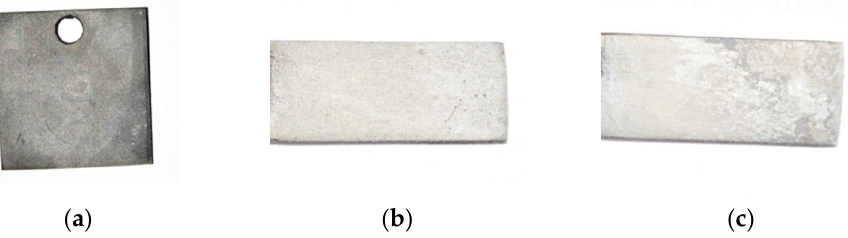
Figure 2. Images of the surface of phosphated steel samples obtained by a digital camera: ( a ) Un- painted phosphate coating from a modified solution; ( b ) White phosphate coating from a solution with the addition of zinc nitrate; ( c ) White phosphate coating from a solution with the addition of calcium nitrate.